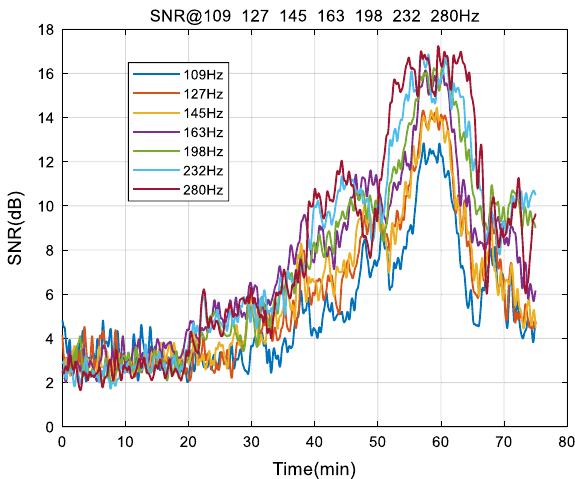
Fig. 6 The signal-to-noise ratio of the signal at each frequency point of array element No. 1 with